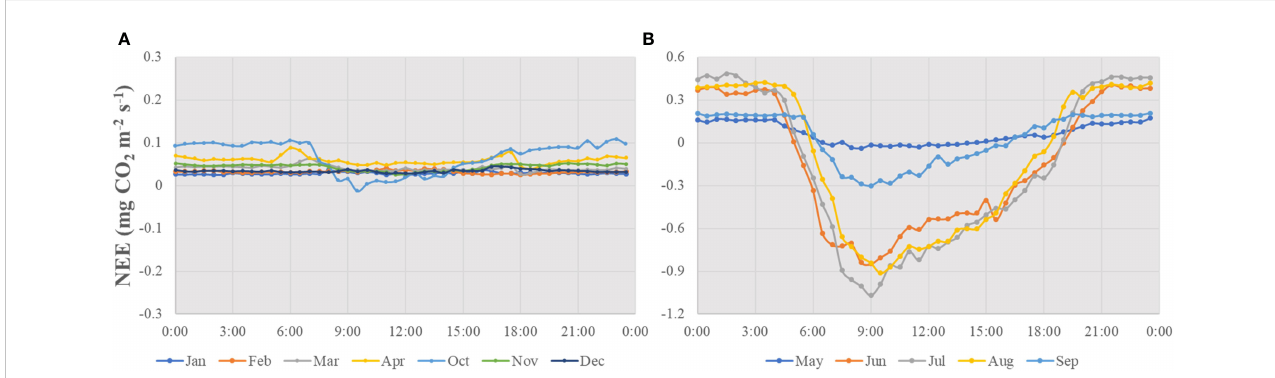
FIGURE 2 Diurnal variations in NEE (net ecosystem CO 2 exchange) on a monthly average from 2008 to 2018: (A) non-growing season, (B) growing season. Jan, January, Feb, February, Mar, March, Apr, April, Jun, June, Jul, July, Aug, August, Sep, September, Oct, October, Nov, November, Dec, December.